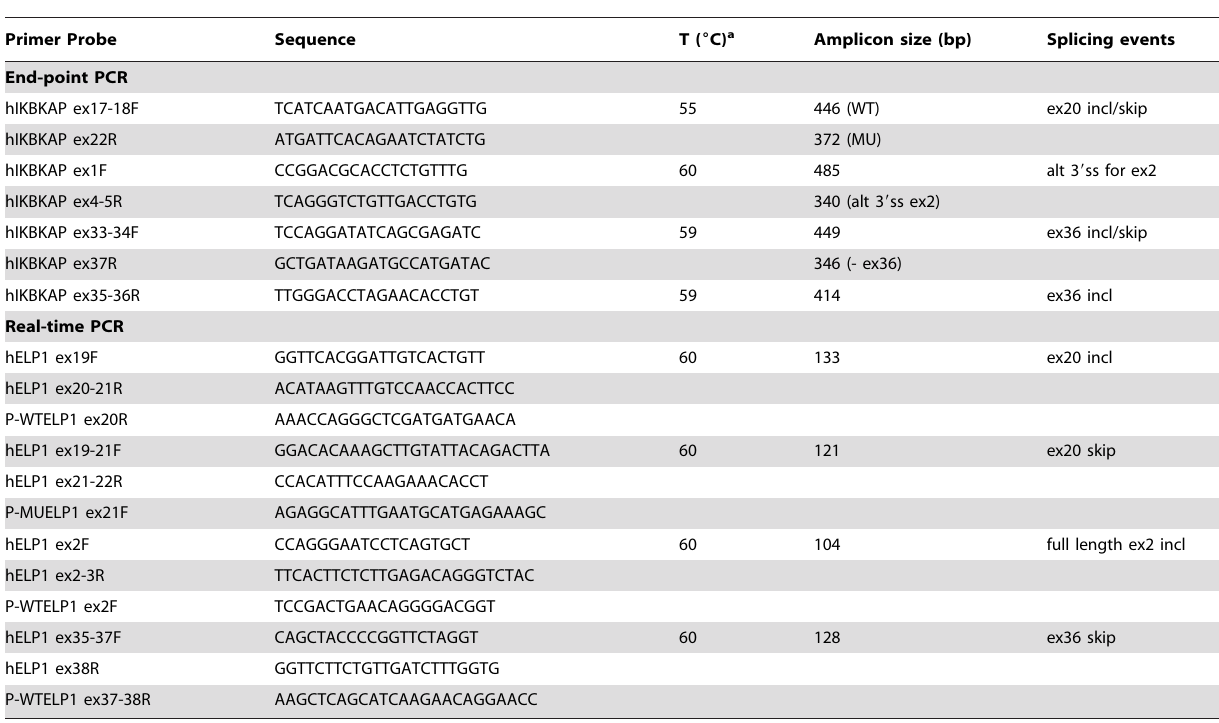
Table 2. Sequence of primers used for end-point and TaqMan real-time PCR.